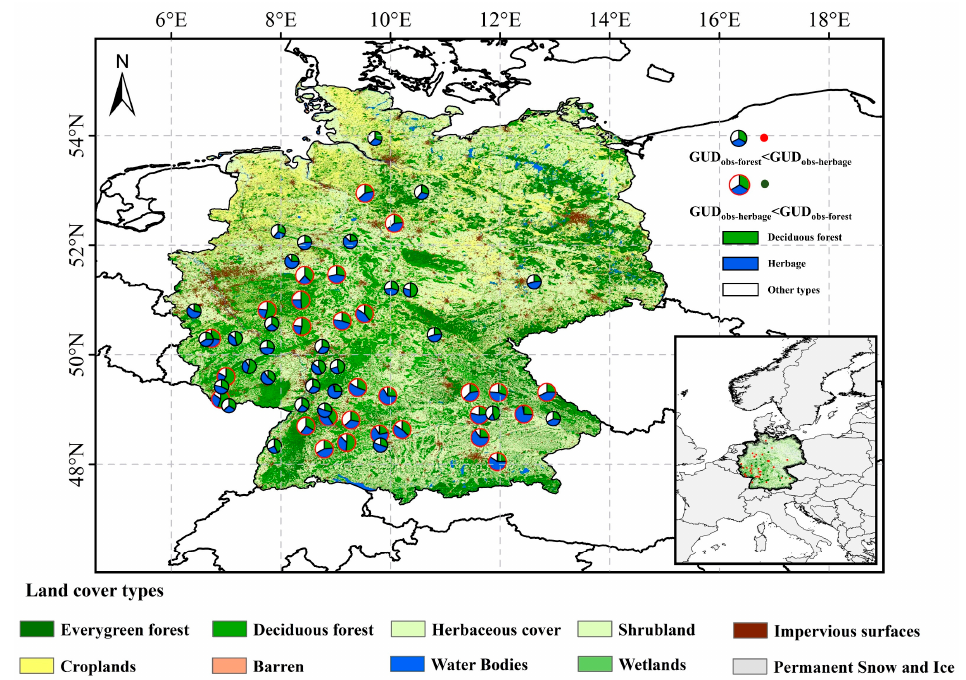
Figure 2. The distribution of the forest-herbage-mixed (FHM) sites were obtained from the Pan European Phenology Database (PEP725).